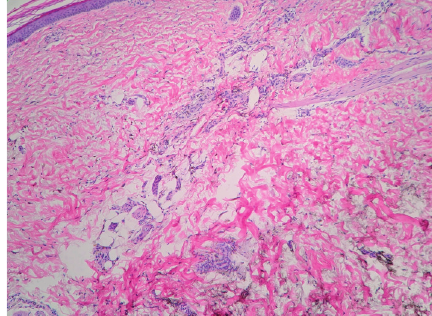
Figure 3: Intermediate magnification shows coarse cytoplasmic granular brown pigmentation within aggregates of macrophages surrounding eccrine structures in the dermis (100x; hematoxylin and eosin